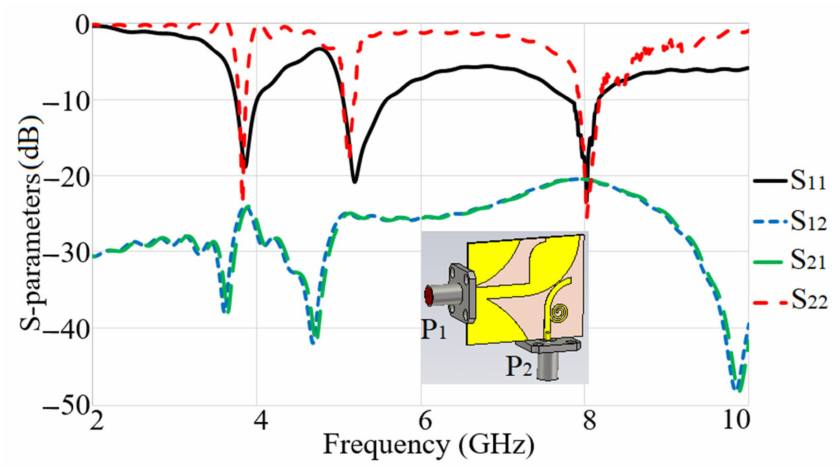
Figure 7. Simulation results of S-parameters for the proposed dual-polarized antenna (P1 and P2 are port 1 and port 2).